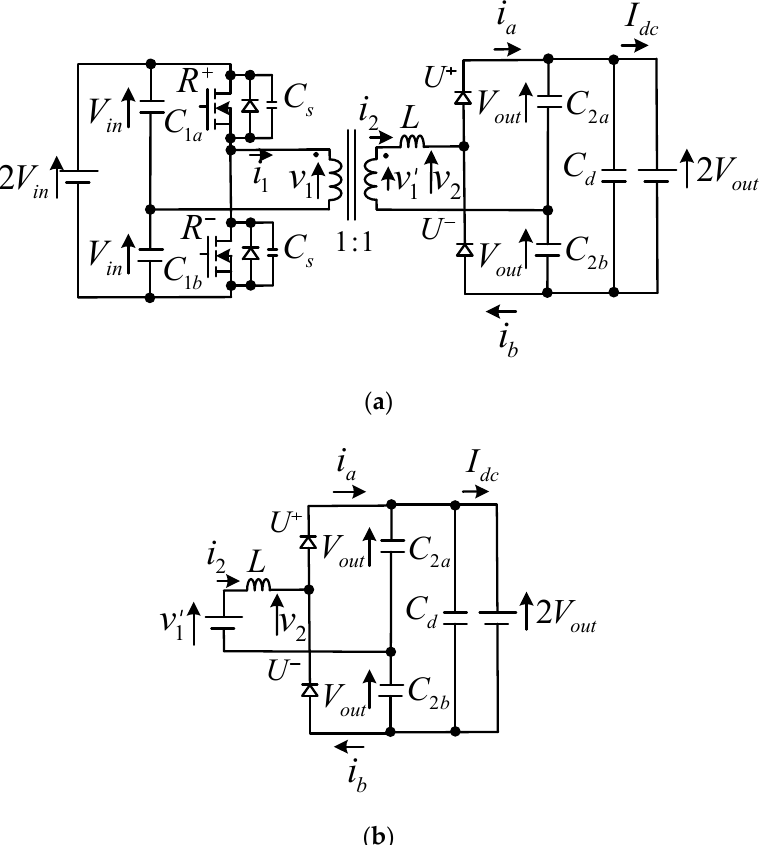
Figure 2. Conventional unidirectional single-active-half-bridge DC-DC converter. ( a ) Circuit configuration. ( b ) Secondary equivalent circuit.